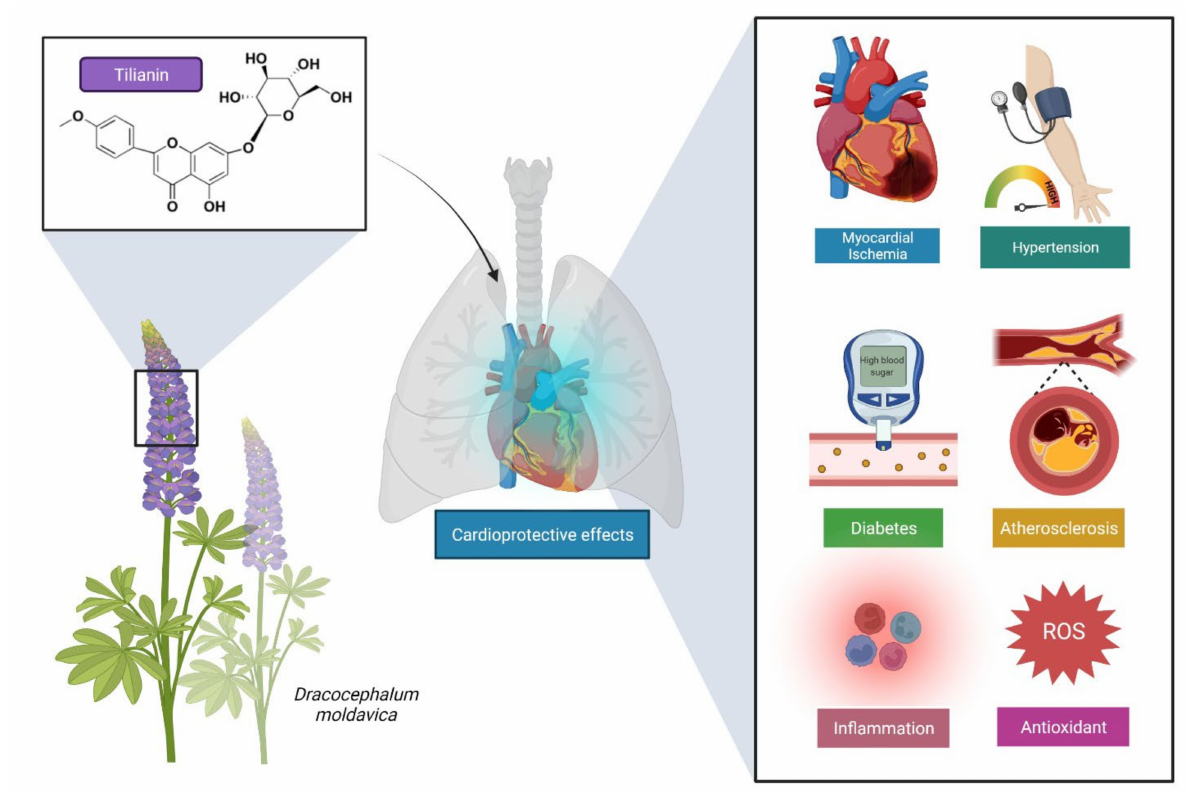
Figure 2. Tilianin, obtained mainly from Dracocephalum moldavica acts as a cardioprotectant and lowers the risk of